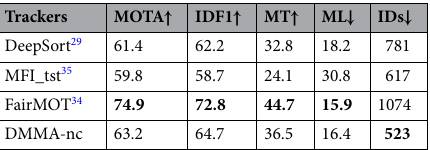
Table 6. Comparison of MOT trackers on MOT16 dataset ( ↓ = the lower the better; and ↑ = the higher the better; bold : best